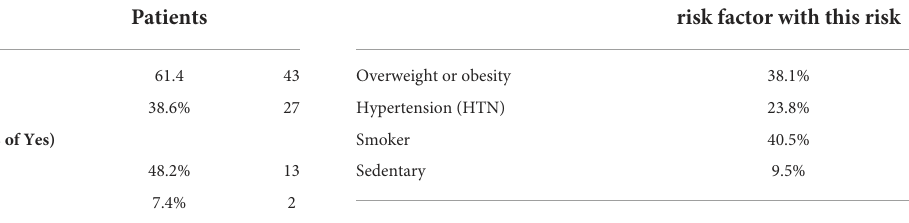
TABLE 8 Patients’ comorbid conditions. TABLE 9 Patients’ CVD risk